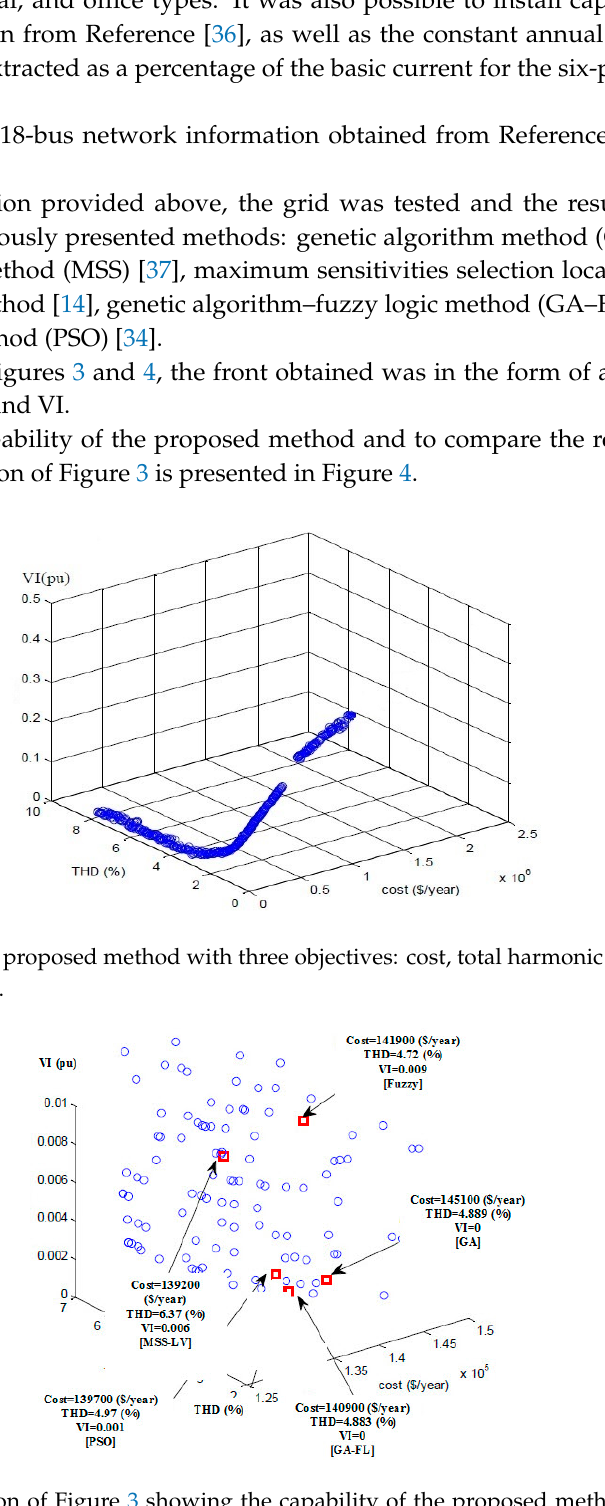
Figure 4. Magnification of Figure 3 showing the capability of the proposed method, along with a comparison of responses using other methods.